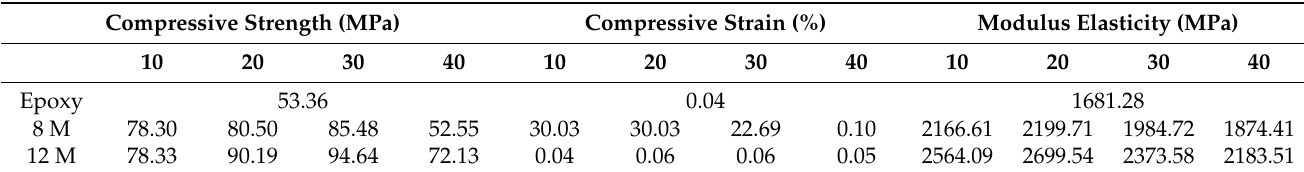
Table 4. Compression properties of GRE pipe without geopolymer filler and GRE filled with geo- polymer filler.